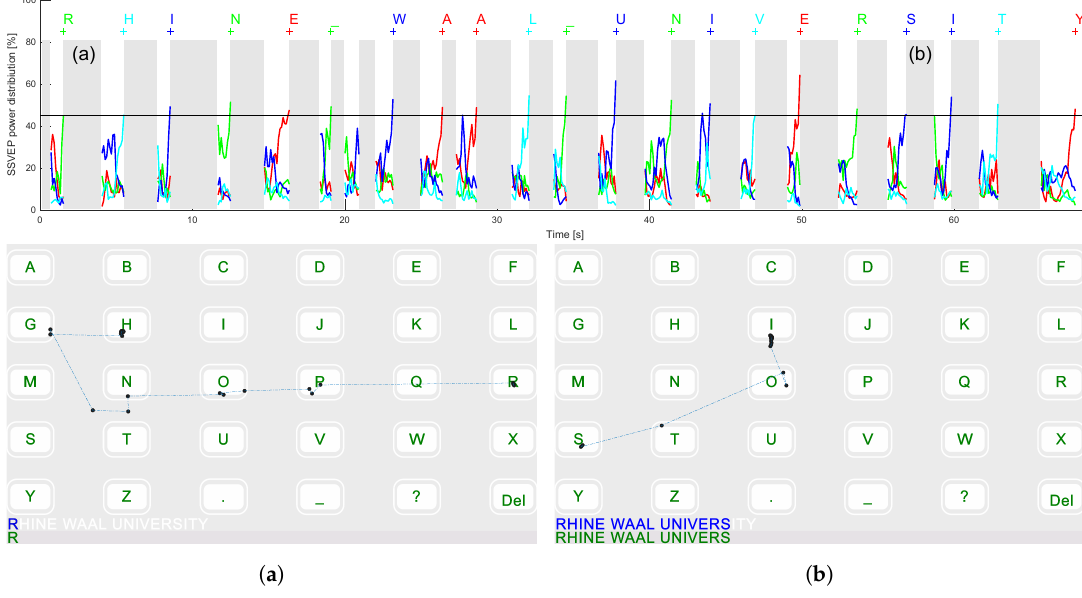
Figure 9. The entire spelling performance for the Hybrid in the example of subject 5. The steady-state visual evoked potentials power estimations are displayed as a function of time; the grey boxes represent the eye tracking phases. Eye tracking paths from ( a ) “R” to “H” and ( b ) “S” to “I” are